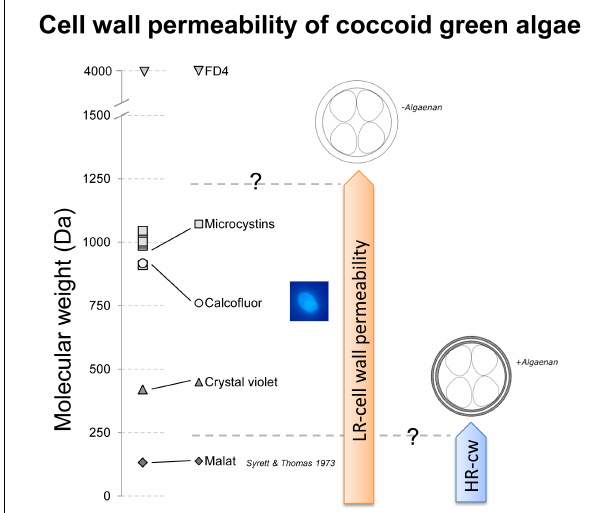
FIGURE 4 | Schematic drawing of cell wall permeability of low resistant (LR)- and highly resistant (HR)-cell wall coccoid green algae for malate, Crystal Violet, Calcofluor, microcystins and FITC-labeled dextran (FD4 – 4 kDa). Malate, Crystal Violet, and Calcofluor were shown to pass the cell wall for LR-cell walls, but only malate was demonstrated by Syrett and Thomas (1973) to pass the cell wall of HR-cell wall types. Microcystins, relevant for biotic interference interaction have a relevant molecular weight to be permeable to LR-cell wall